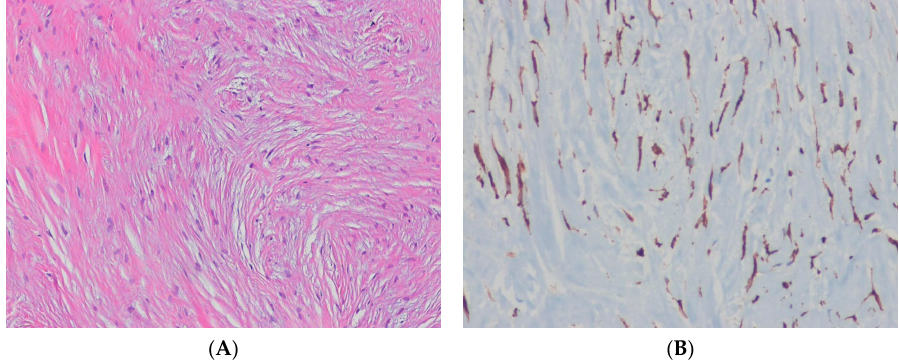
Figure 4. Low-grade fibromyxoid sarcoma. ( A ) The tumor shows bland-appearing spindle cells in the myxoid and fibrous stroma, with short fascicles or a storiform pattern (H&E stain, × 100). ( B ) The tumor cells show cytoplasmic expression for MUC4, indicating the presence of underlying MUC4 upregulation (immunohistochemical stain for MUC4, ×